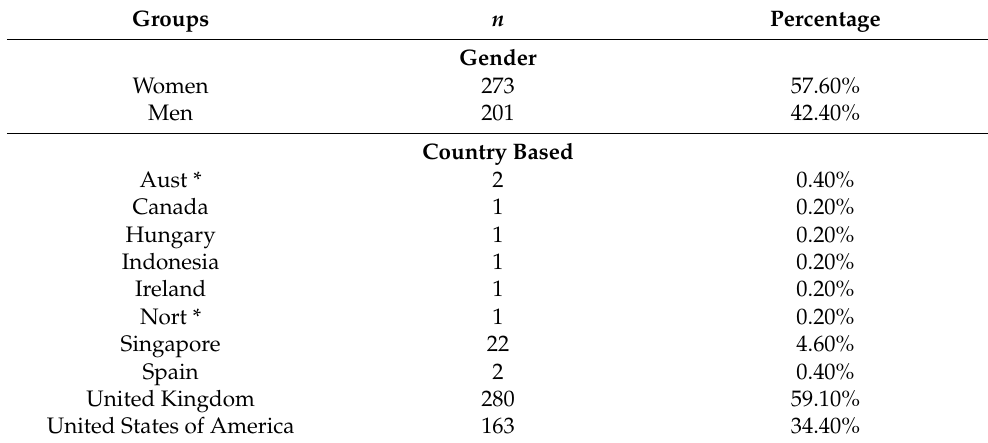
Table 1. The Demographic Characteristics of